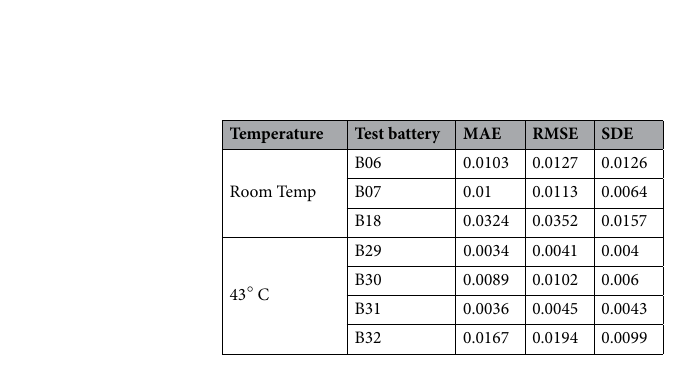
Figure 7. Plots of actual and estimated SOH, and error for ( a ) battery CS2-34, ( b ) battery CS2-38 of CALCE dataset.